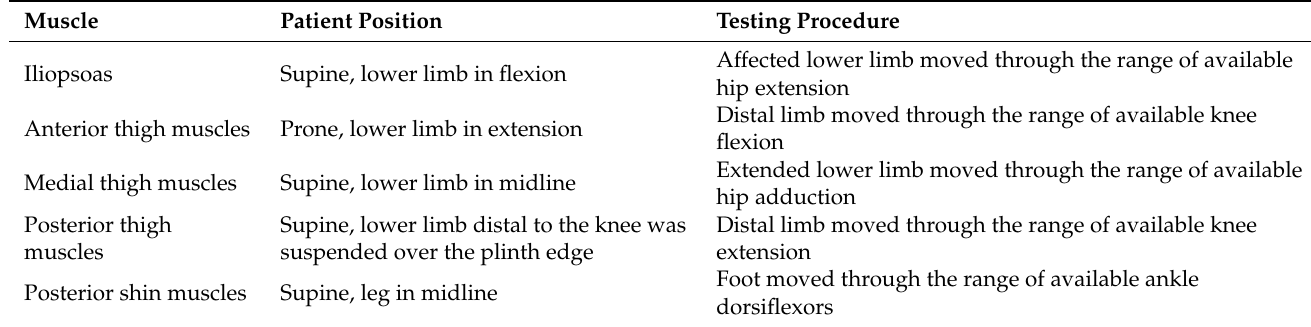
Table 1. Modified Ashworth Scale